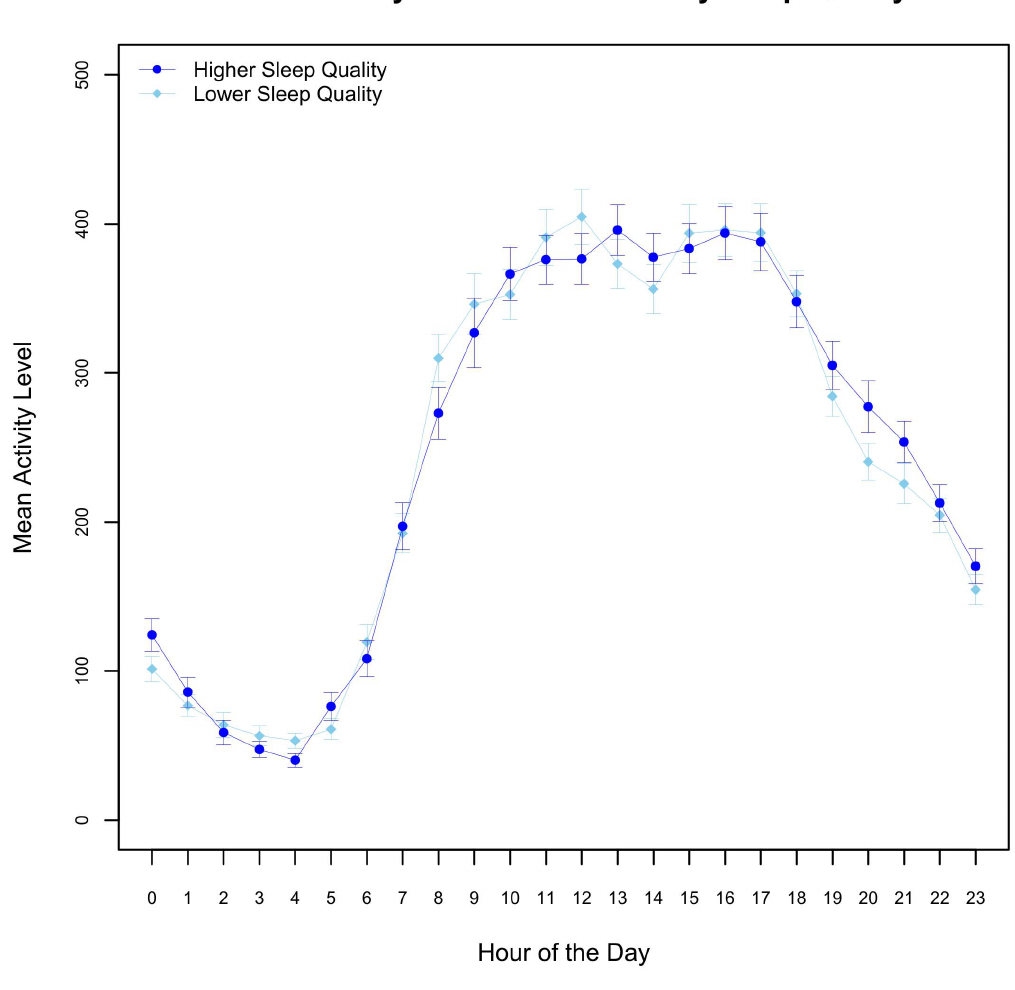
Figure 3. A comparison of mean physical activity level by hour of the day between days following nights of highest individual sleep quality and those following nights of lowest individual sleep quality. There was a clear circadian rhythm of physical activity overall, but higher levels of physical activity were seen in participants who had had a night of better quality sleep.